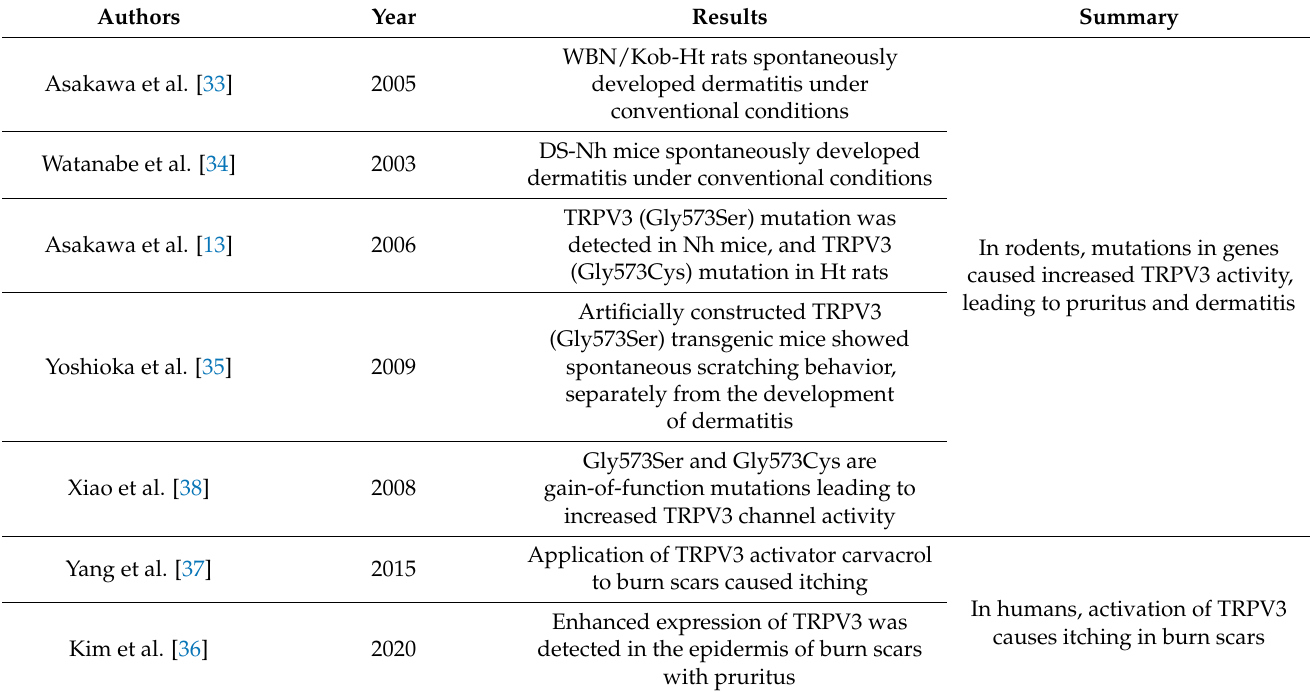
Table 1. Evidence for TRPV3-mediated